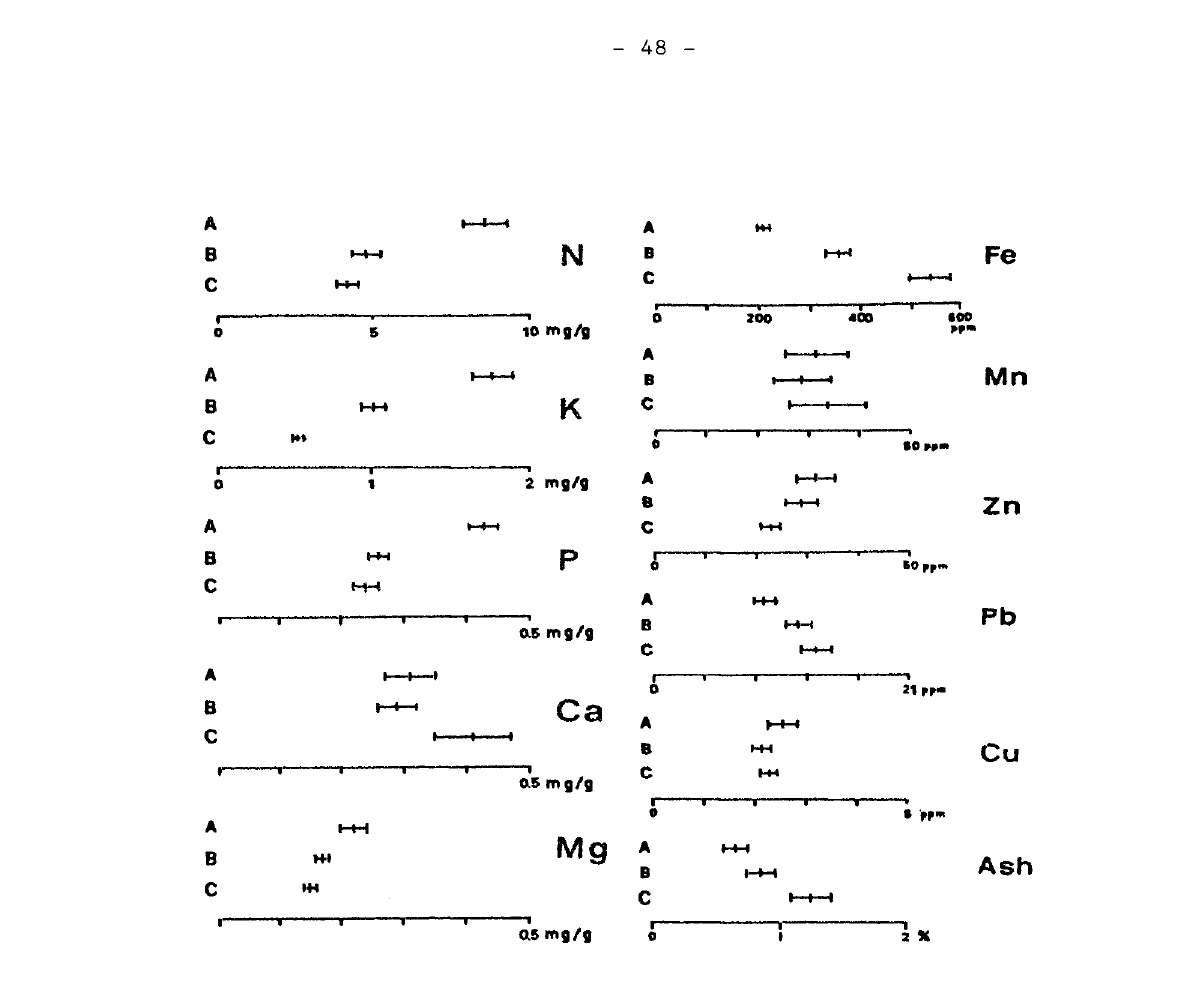
Figur 1. Vertikal fbrdelning av mineraler och aska i Cladina